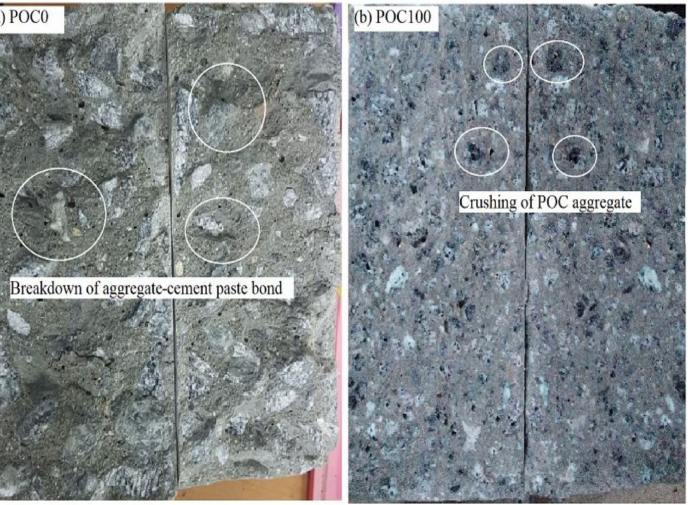
Figure 6. Cross-sections of the failed specimens under splitting tensile test. ( a ) POC0 and ( b ) POC100